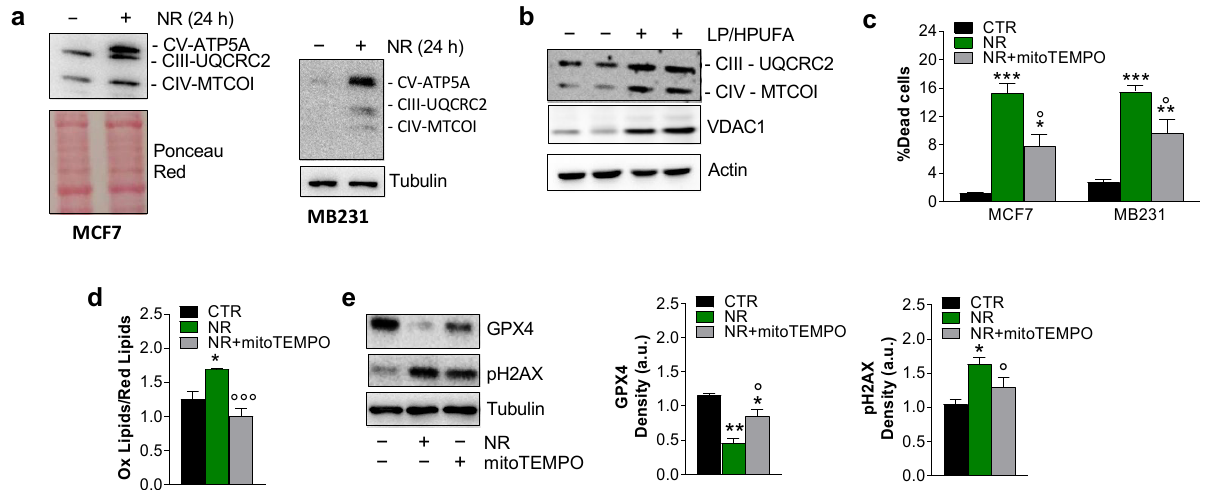
Figure 5. Ferroptosis is induced in a mitochondria-dependent manner in cancer cells. ( a , b ) Mitochondrial mass was evaluated by Western blot analysis of electron transport chain subunits and/or VDAC1 in breast cancer cell lines cultured under 24 h nutrient restriction (NR) ( a ) or breast cancer masses explanted from mice fed with LSAA/HPUFA or ND ( b ). Ponceau red, Tubulin or Actin were used as loading controls. ( c – e ) Breast cancer cells were treated with 10 μ M mitoTEMPO 1 h prior to 24 h NR and used for cell death ( c ) and lipid peroxidation ( d ) determination, and Western blot analysis of GPX4 and pH2AX ( e ). Densitometric analysis of GPX4 and pH2Ax immunoreactive bands are reported and normalized to Tubulin loading control. Data are expressed as mean ± S.D. ( n = 3; * p < 0.05, ** p < 0.01, *** p < 0.001, vs. CTR; ° p < 0.05, °°° p < 0.0001 vs. NR). Immunoblots reported are representative of three independent experiments for cultured cells and from n = 2 out of n = 6 mice/group yielding similar results.